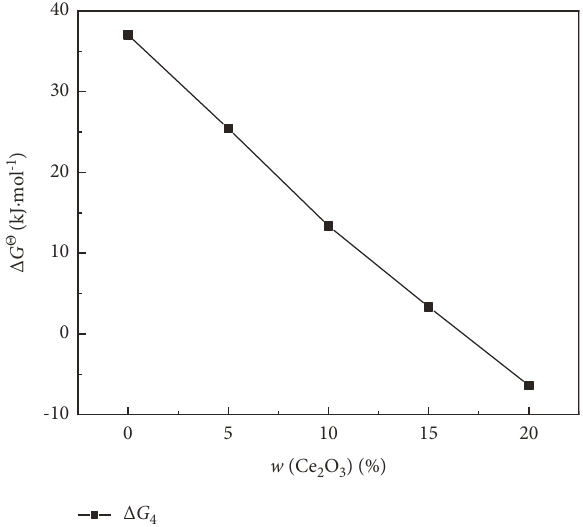
Figure 7: Gibbs free energy of the slag-steel interface chemical reaction with different Ce 2 O 3